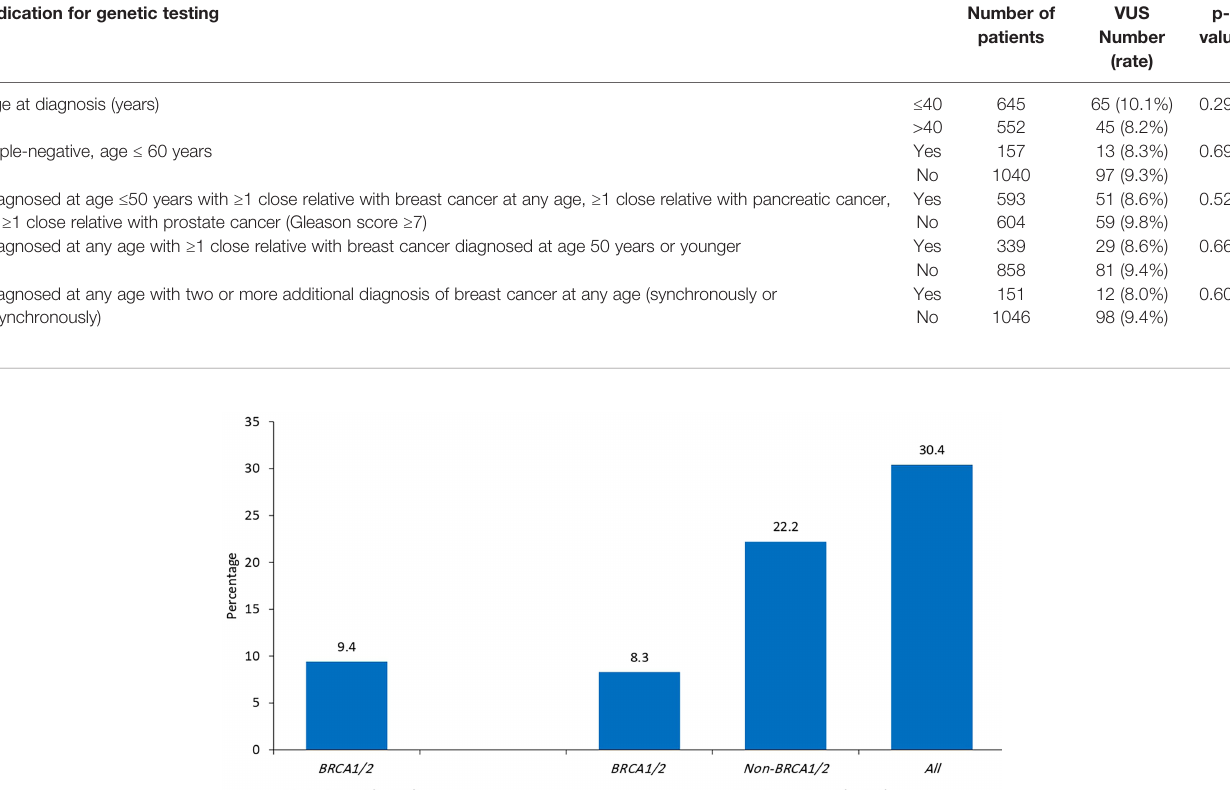
TABLE 2 | VUS rates in relation to indications for genetic testing (n = 1,197). Indication for genetic testing